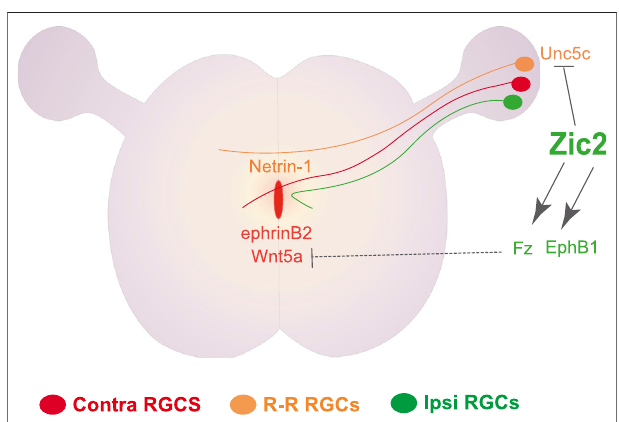
FIGURE 1 | Transcriptional control of ipsilateral trajectories in the visual system. The TF Zic2 controls the trajectory of ipsilateral RGC axons through the transcriptional upregulation of the tyrosine receptor EphB1, which in turn mediates repulsion from glial cells at the midline that express ephrinB2. Concomitantly, Zic2 induces the expression of several Wnt receptors and cytoplasmic proteins to inhibit the attractive response towards Wnt5a -also expressed at the midline-experienced by contralateral RGCs. Zic2 also represses the expression of the Netrin1 receptor Unc5c in iRGCs to allow axon growth through a Netrin1-expressing area at the